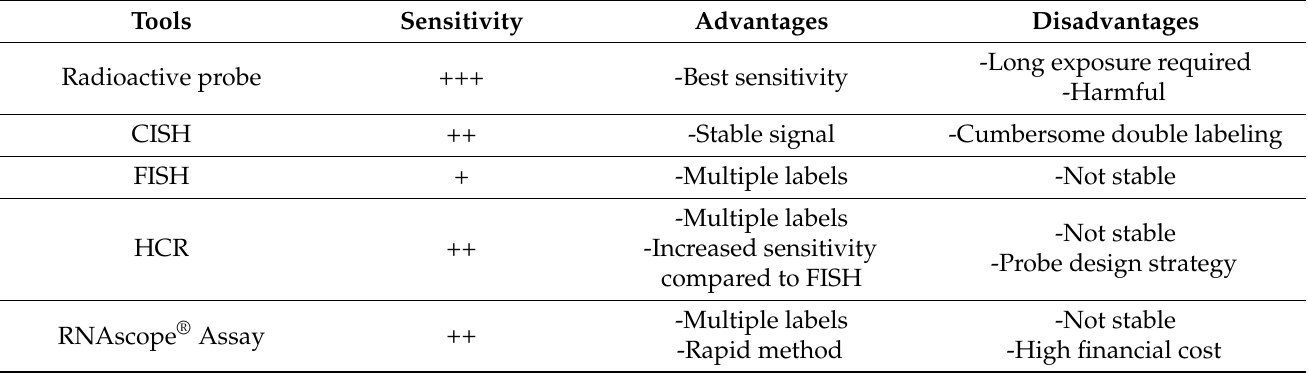
Table 2. Sensitivity, advantages and disadvantages of the different in situ hybridization approaches. ((+) low, (++) medium, (+++) strong